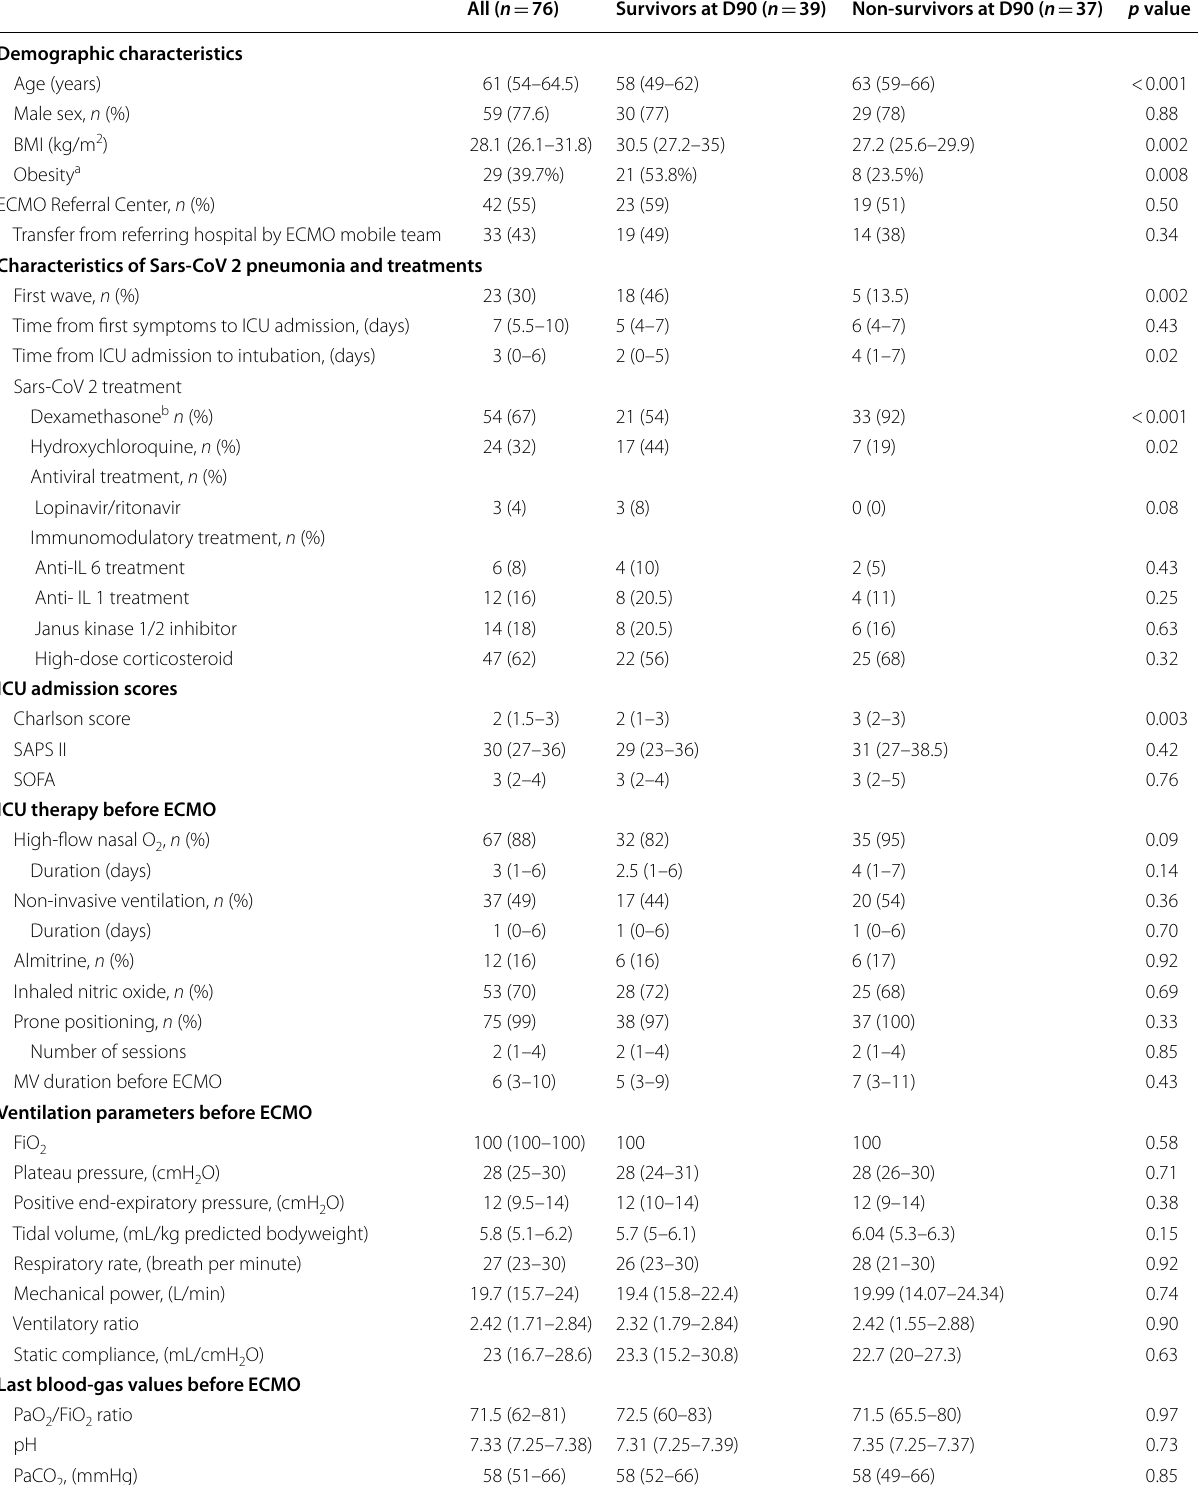
Table 2 Comparison of patient’s characteristics according to their survival at day 90 in univariate analysis